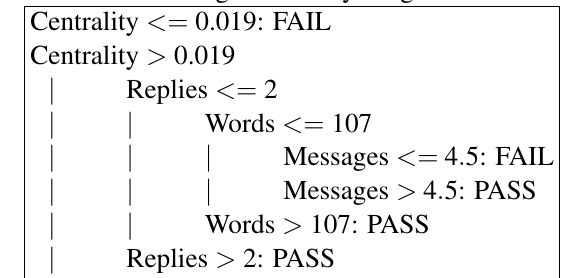
Table 7: Decision tree generated by J48graft over